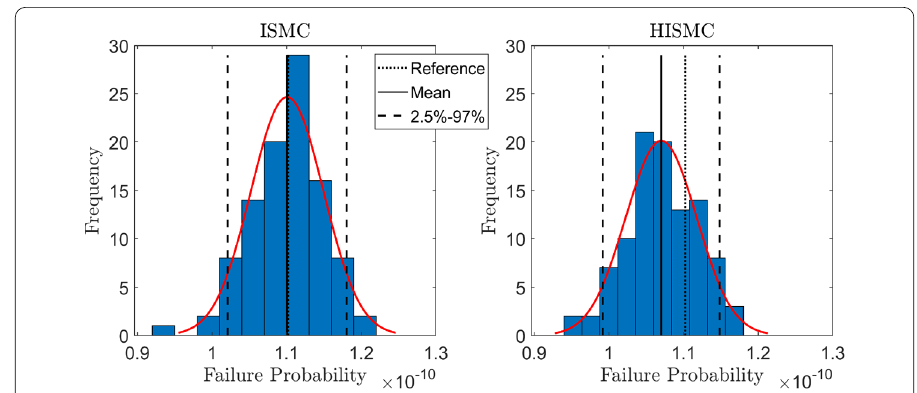
Figure 4 VCO: Empirical probability distributions of ISMC and HISMC from N rep = 100 experiments with mean 1.10 × 10 –10 and 1.07 × 10 –10 ,